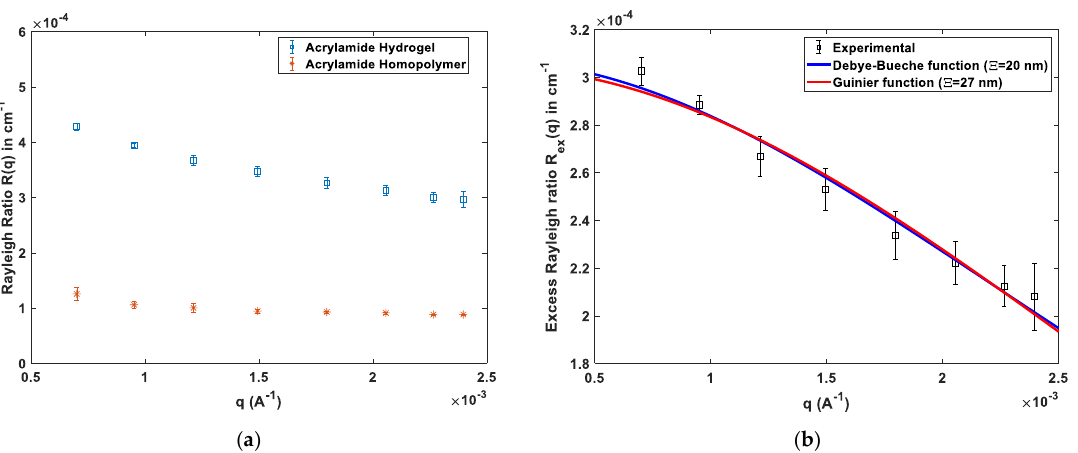
Figure 10. ( a ) Experimental data relative to the SLS analysis of a polyacrylamide hydrogel and the analogous polyacrylamide homopolymer (Rayleigh ratios at different scattering angles for H4 and L2). ( b ) Measured excess Rayleigh ratio for hydrogel H4 and data fitted using the Debye-Bueche and Guinier functions.